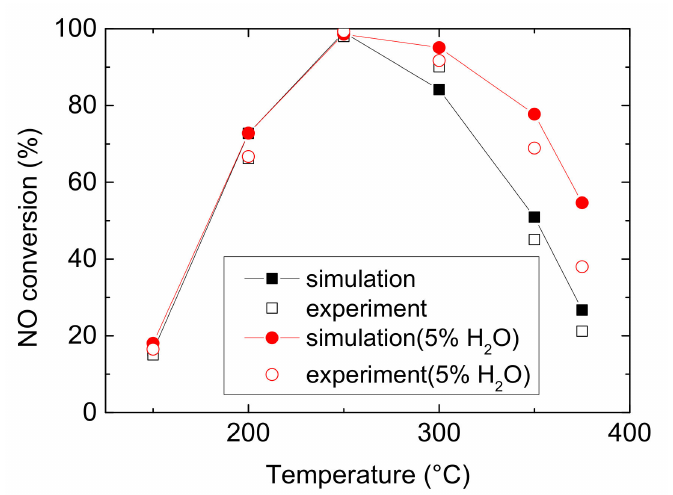
Figure 1. NO conversion comparison of experimental and simulated values in 150–375 ◦ C [23].